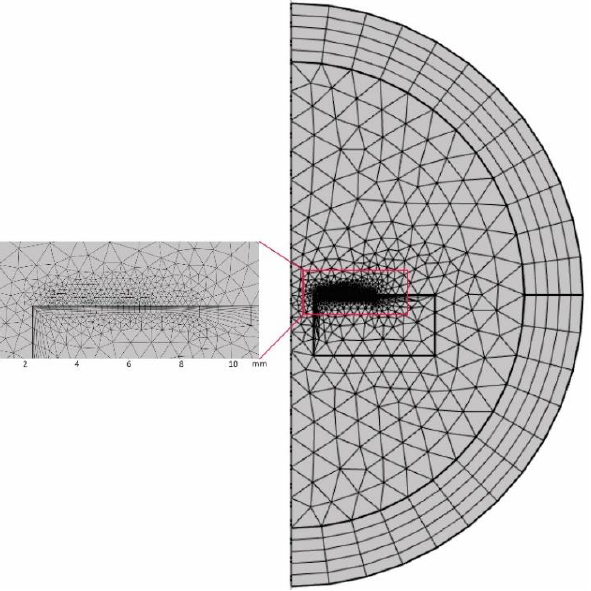
Figure 6. Visualization of the meshed geometry for the coil, part, and infinite domains.